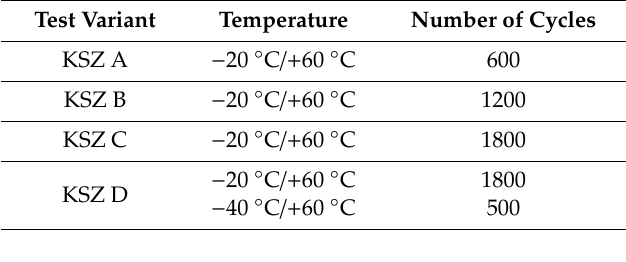
Table 4. Sample exposure data—thermal shock chamber.